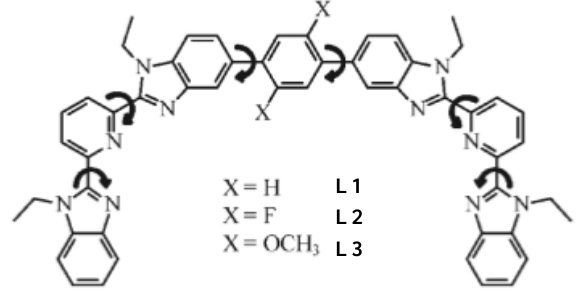
Figure 19. Structure of ligands L resulting from Suzuki–Miyaura coupling of two tridentate 2,6-bis(benzimidazole-2-yl)pyridine binding units at the 1 and 4 positions of a rigid phenyl spacer. Reproduced from [214], with permission from ACS, 2011.